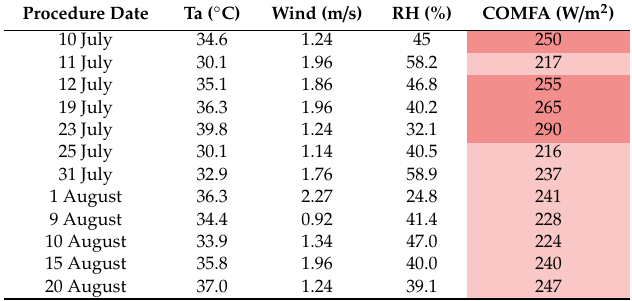
Colors representing levels of thermal perception are based on the color index in Table 2. Table 6. Summary of procedure results. Columns show the 12 procedures with recorded facial skin temperatures (average of five points: Ear, cheek, nose, chin, and temple) collected every 5 min. Rows represent participants’ self-reported thermal comfort levels collected every 15 min.